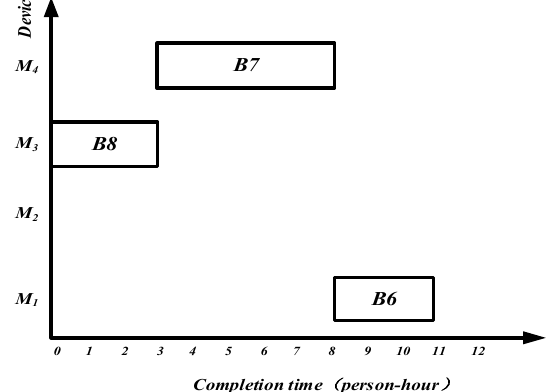
Figure 12. Gantt chart of operation string T B12 allocated to workshop f 2 with 11